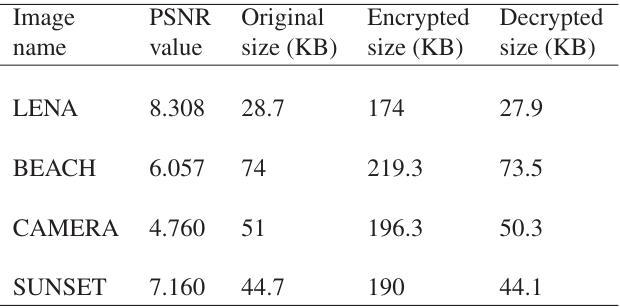
Figure 9. Decoded message after decryption process